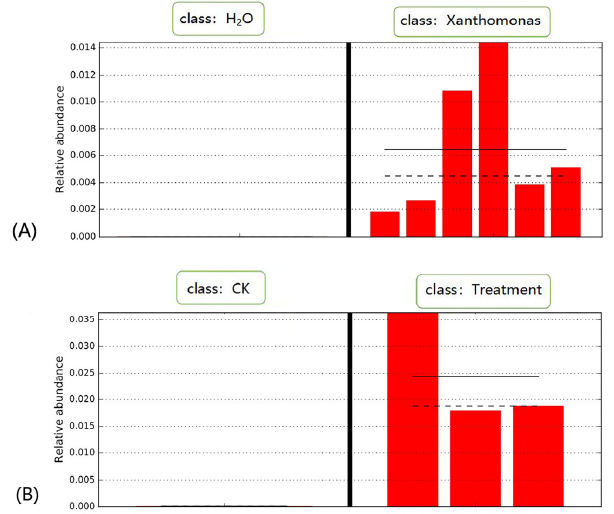
Figure 10. Relative content changes of plants inoculated microorganisms. ( A ) Common soybean inoculation with X.phaseoli strain CFBP6546R. Compared to the 6 samples inoculated with H 2 O, the content of X.phaseoli in 6 samples, inoculated with X.phaseoli strain CFBP6546R, increases significantly ( p < 0.01). ( B ) Maize roots inoculation with R.irregularis. Compared to the 3 control samples, the content of R.irregularis in 3 samples, inoculated with R. irregularis DAOM-197198, increases significantly ( p < 0.01).